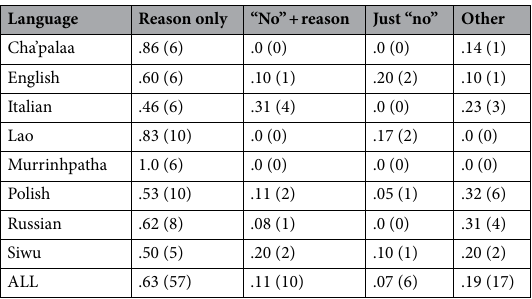
Table 2. Rejection design. Proportion ( n ) of rejection strategies: (i) only giving a reason, (ii) saying “No” + giving a reason, (iii) just saying “No”, or (iv) conveying rejection in another way, such as visibly refusing to cooperate by turning